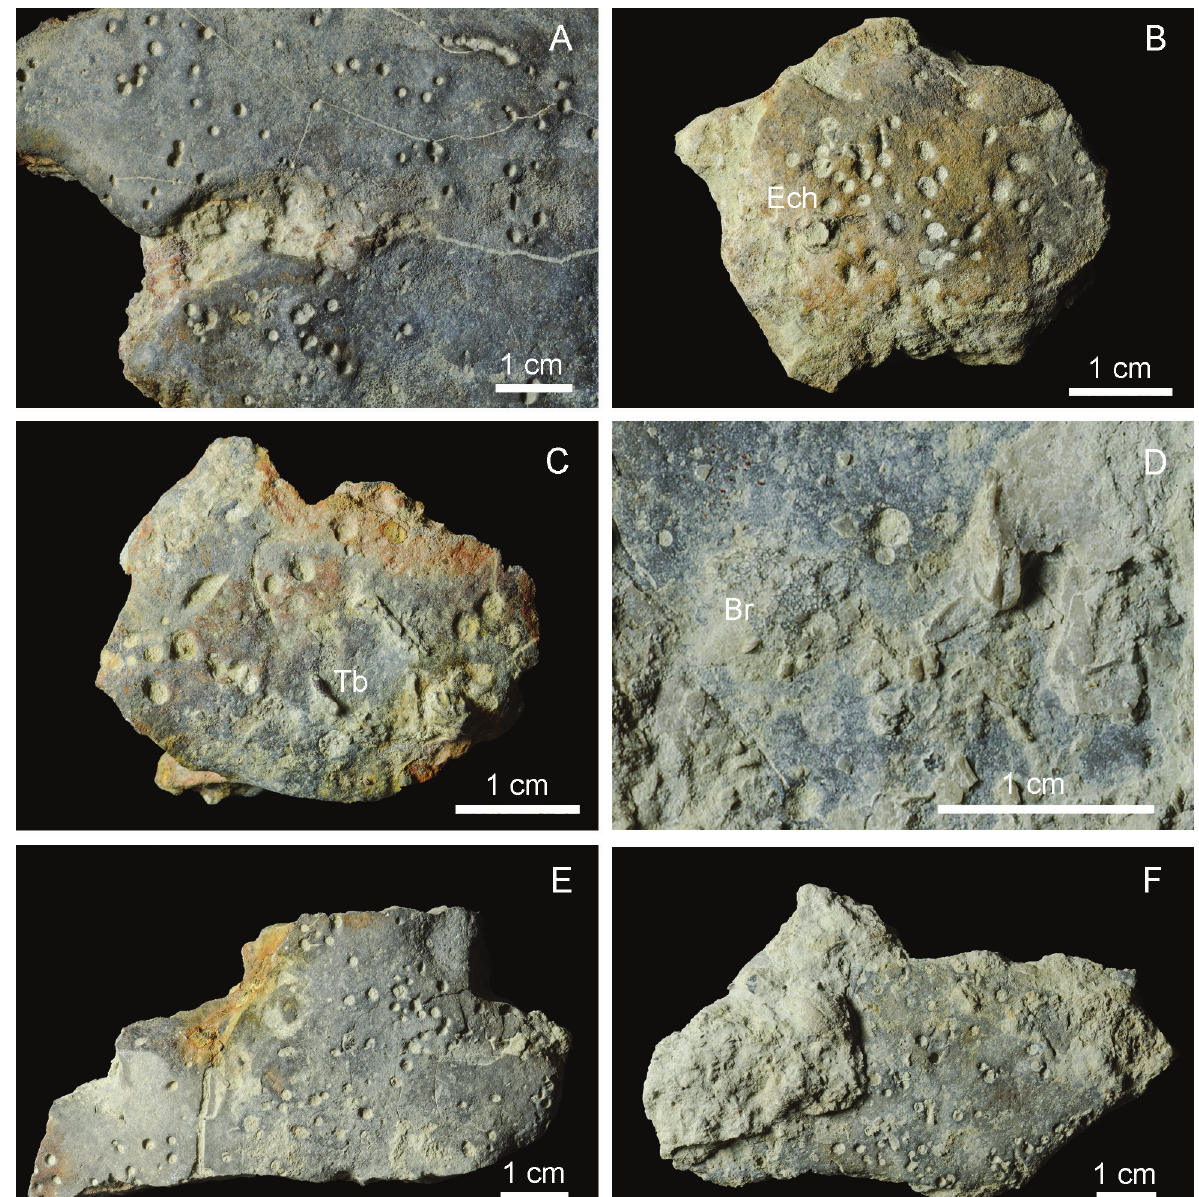
Fig. 3. Päärdu hardground surfaces with encrusters and abundant Trypanites borings from the Rumba Formation, early Telychian of the Velise River, western Estonia. A , Trypanites borings (GIT 362-100); B , discoid echinoderm holdfast (GIT 362-101); C , possible tabulate corals (auloporids?) (GIT 362-105); D , bryozoa (possibly trepostome) (GIT 362-104); E , hardground surface with Trypanites borings (GIT 362-102); F , hardground surface with Trypanites borings (GIT